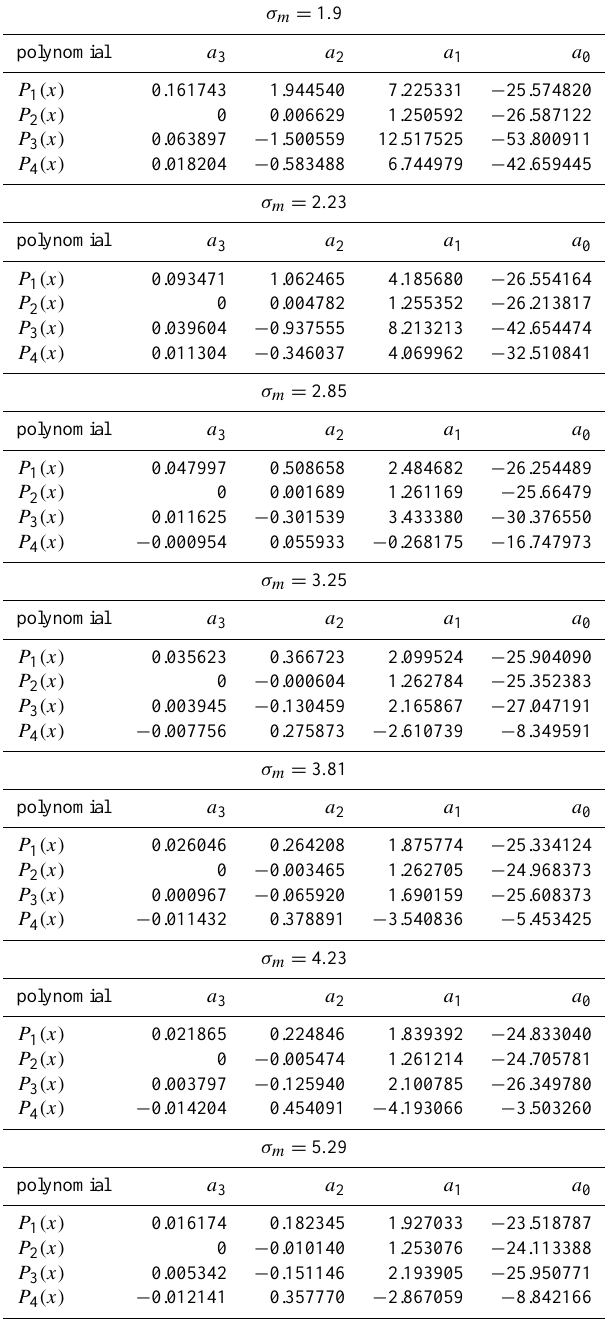
Table A1. Coefficients a k ,k = 1 ,..., 4 for the fitting polynomials as given by Eq. (A1) for different geometric standard deviations σ m of the underlying ice crystal mass distribution of log-normal